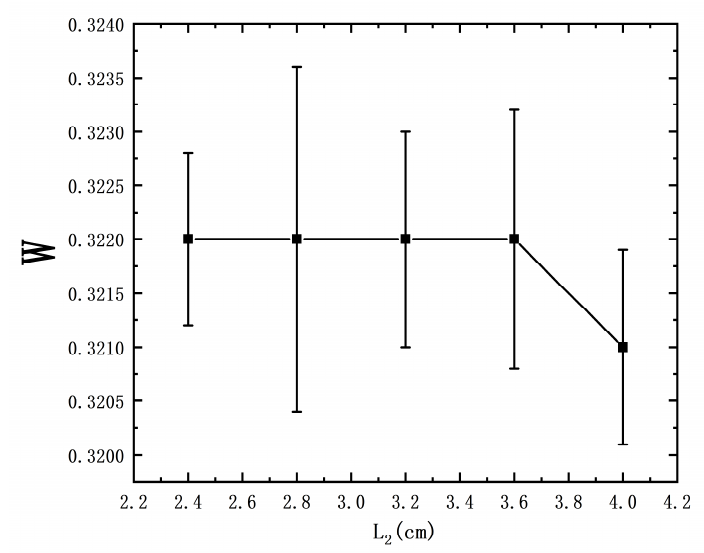
Figure 10. The transmission probability W versus L 2 .